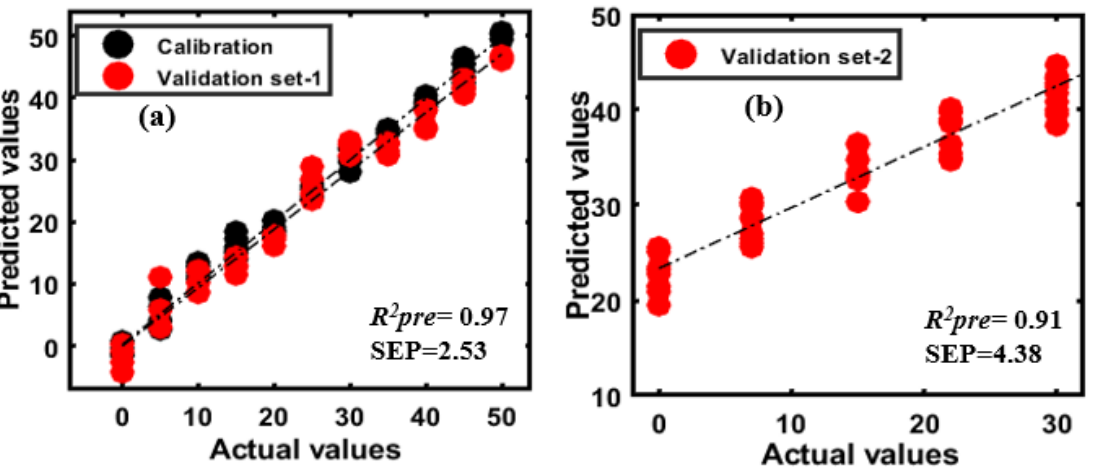
Figure 11. PLSR prediction plots ( a ) for peanut-adulterated almond (first variety); ( b ) results for the